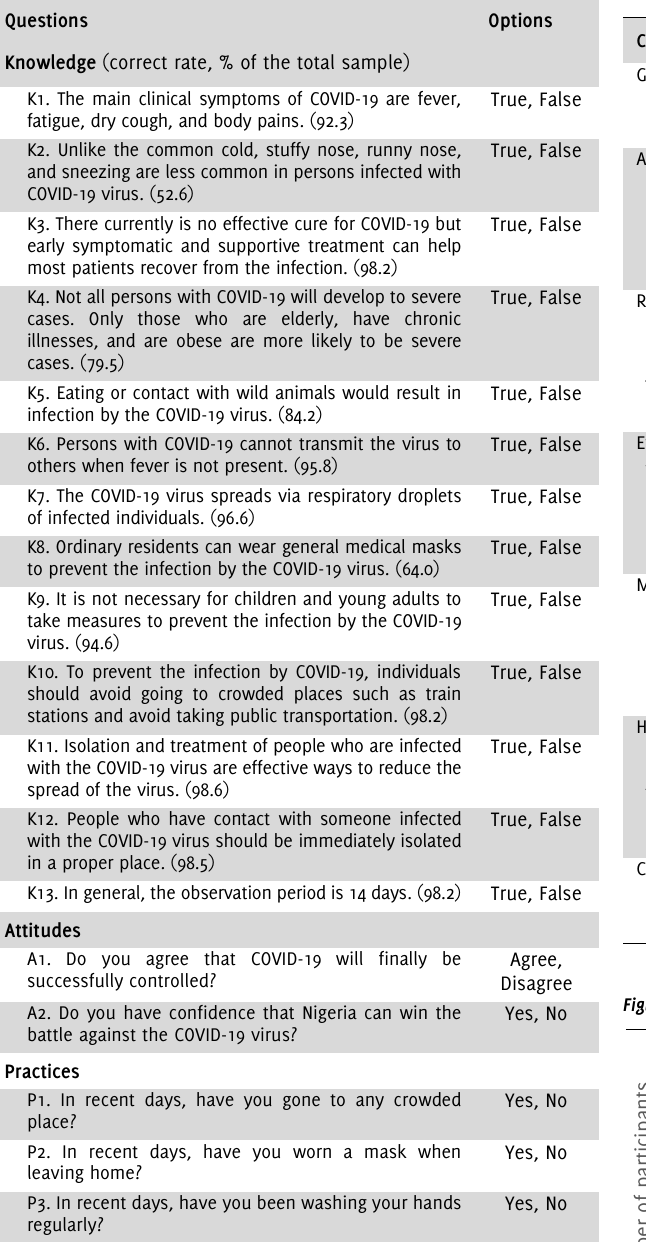
Table 1 . Elements of the Questionnaire and Responses. Table 2 . Demographic Characteristics of Participants and Knowledge Score About COVID-19 by Demographic Variables.